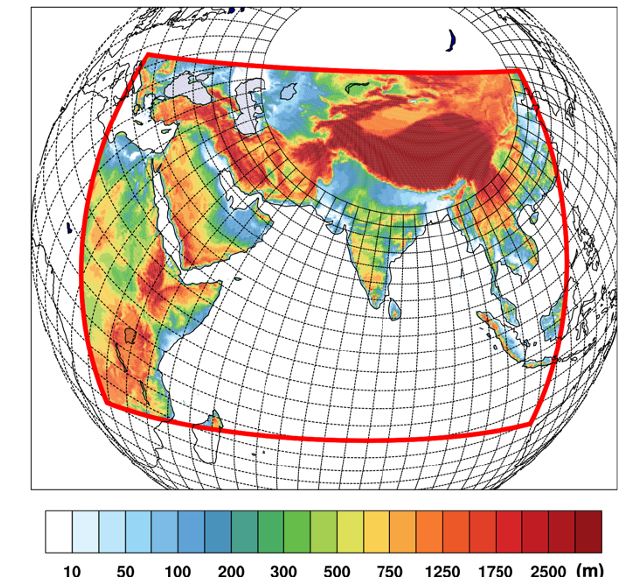
Figure 1. ROM configuration. The red frame shows the coupled ocean–atmosphere CORDEX domain. The black lines indicate the grid of the MPIOM/HAMOCC models (only every 12th line is shown). Color scale represents